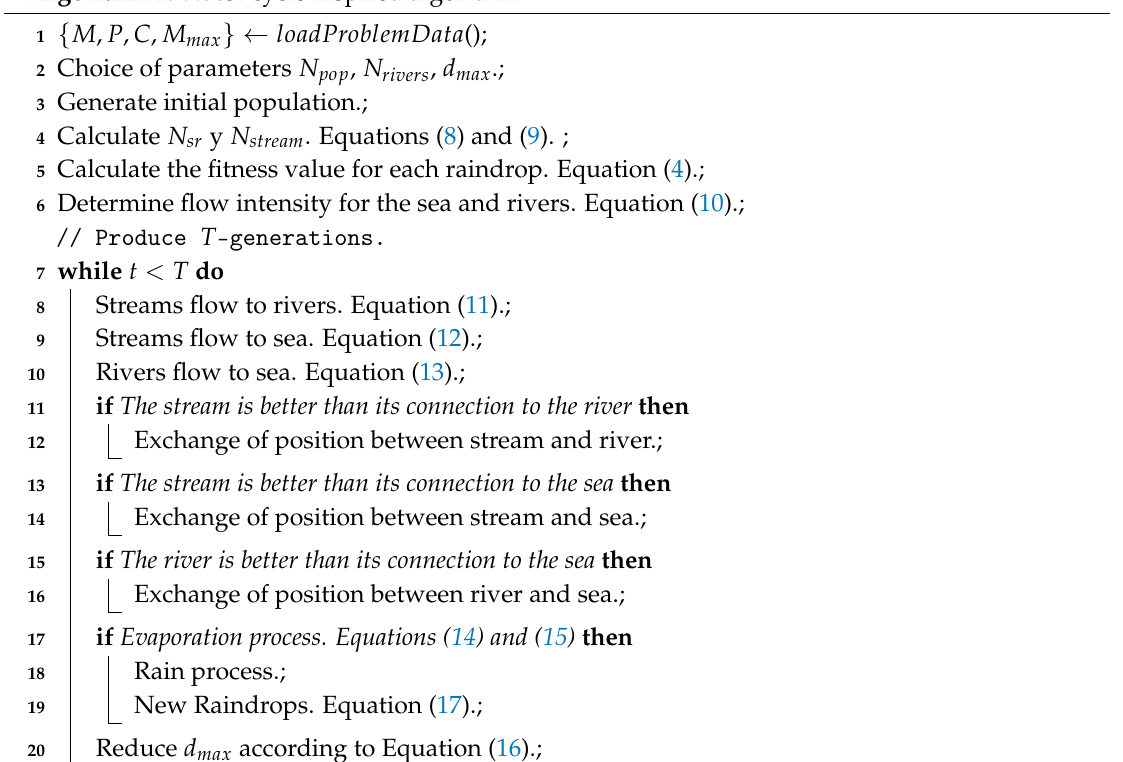
Algorithm 1: Water cycle inspired